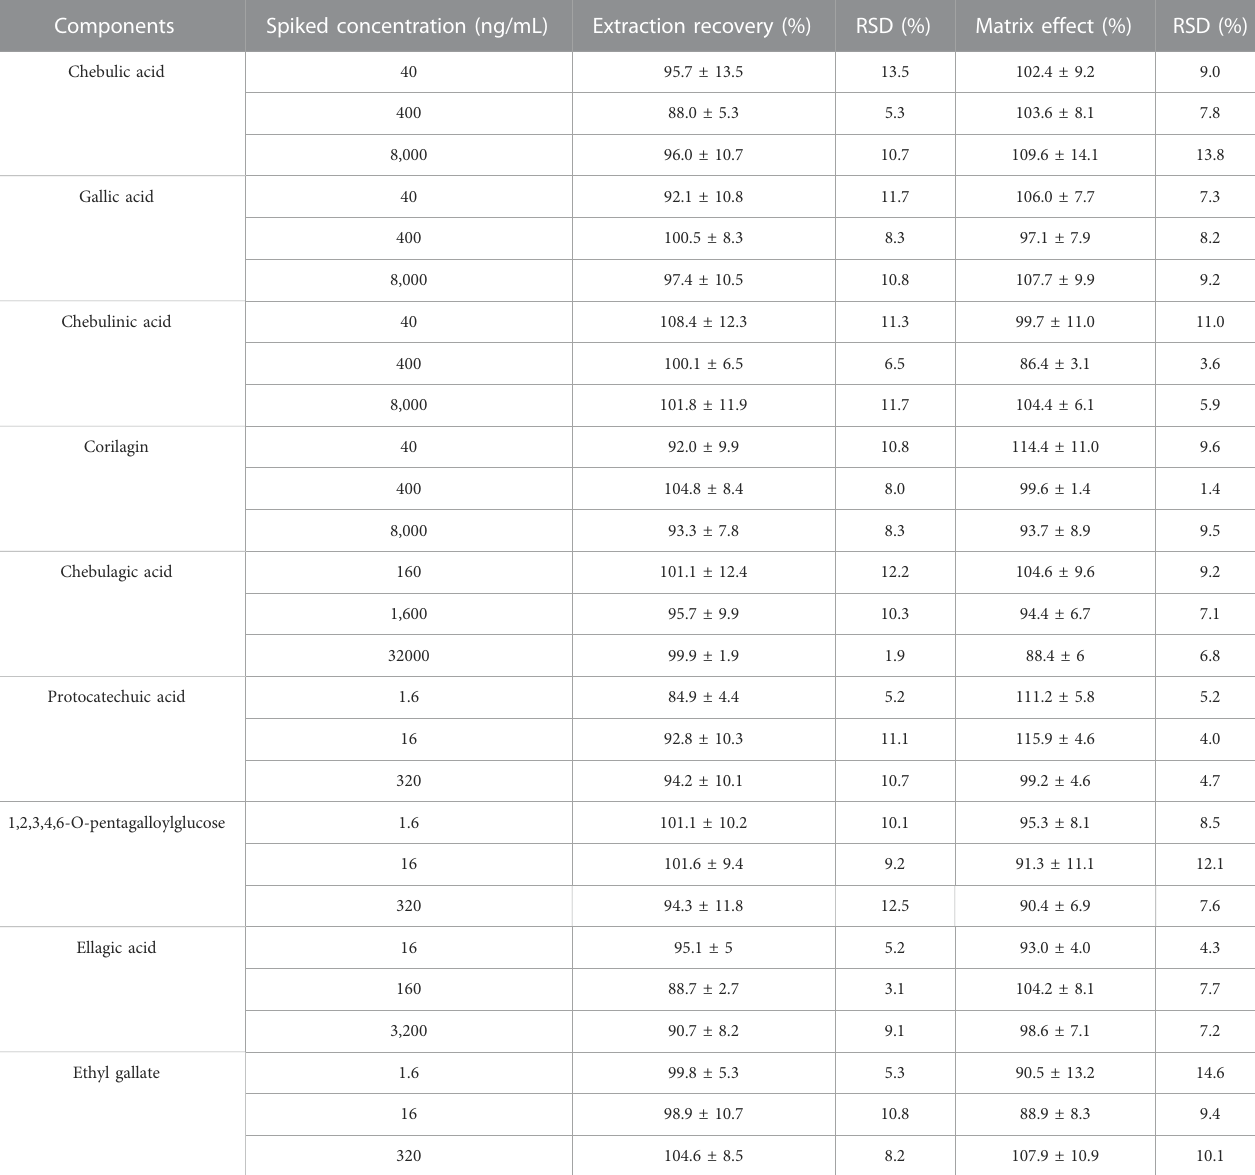
TABLE 5 Extraction recovery and matrix effects of nine analytes in rat plasma (n = 6).